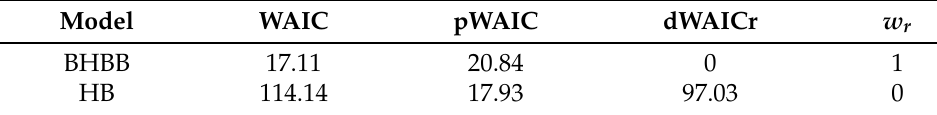
Table 4. WAIC value of BHBB and HB under model